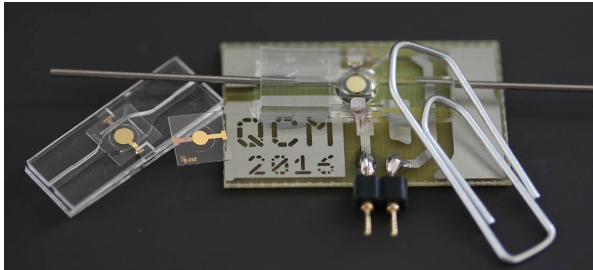
Figure 2. Microdevices used in our studies at different integration levels: microfluidic chip containing a QCM (left), small QCM ob- tained after dicing the microstructured quartz substrates (middle- left), the ready-to-use microfluidic chip mounted on a PCB with a paper clip for comparison of sizes